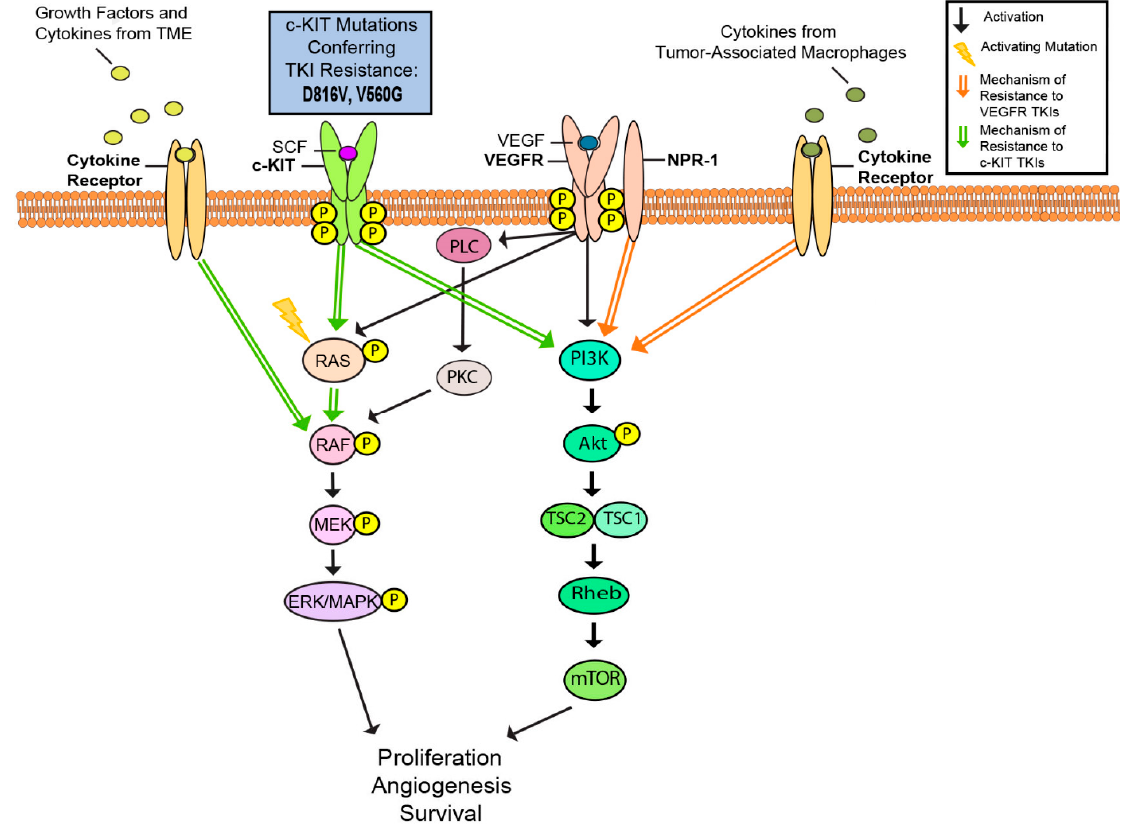
Figure 3. MAPK, PI3K, and angiogenic reactivation confers resistance to c-KIT and VEGFR TKIs [1]. Activating c-KIT mutations and pathway reactivation by growth signals from the tumor microenvironment (TME) contribute to resistance to c-KIT TKIs [129,130] . Angiogenic signaling from tumor-associated macrophages as well as pathway reactivation via VEGFR co-receptor NRP-1 may contribute VEGFR TKI resistance in melanoma [136–138] .